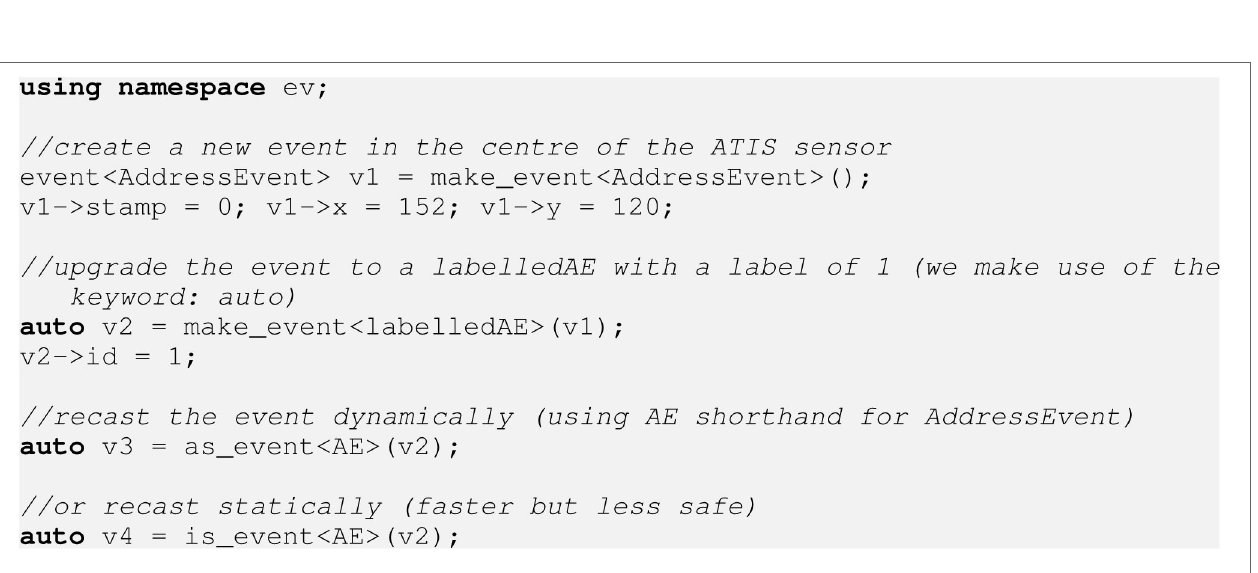
FIGURe 2 | Event-types and inheritance, purple/dashed boxes show possible additions to the library to support the integration of other sensory modalities and information from additional computing modules.